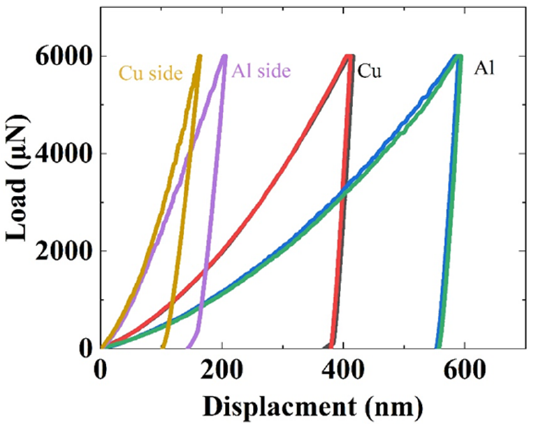
Figure 5. The load ‐ displacement curves of the indents shown in Figure 4c. Figure 5. The load-displacement curves of the indents shown in Figure